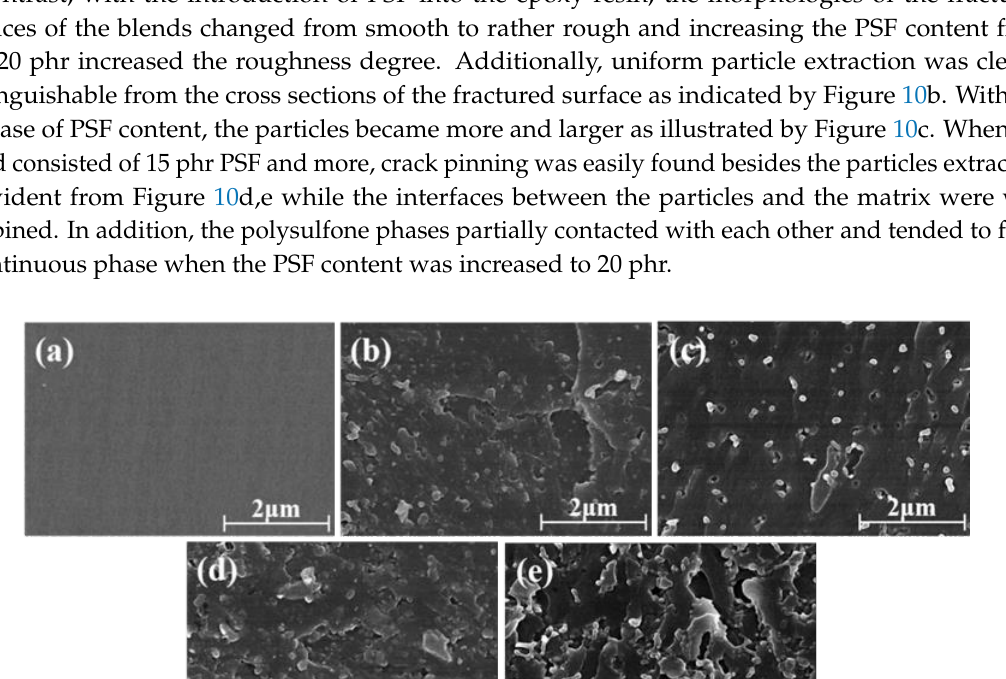
Figure 9. The Impact strength of the PSF/epoxy blends as a function of PSF content.